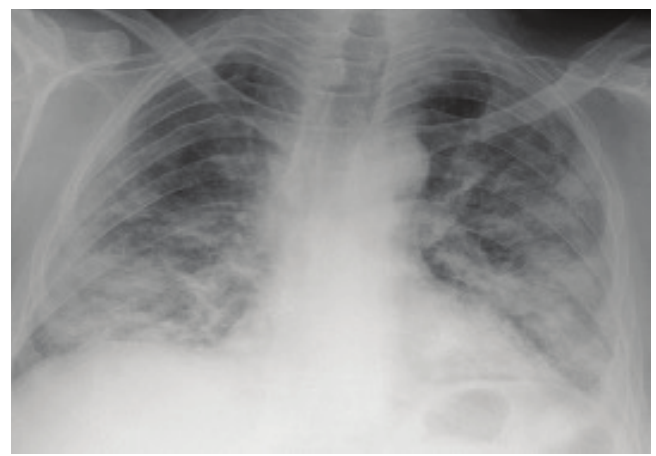
Figure 2 - Chest radiography of After ten day than Covid 19